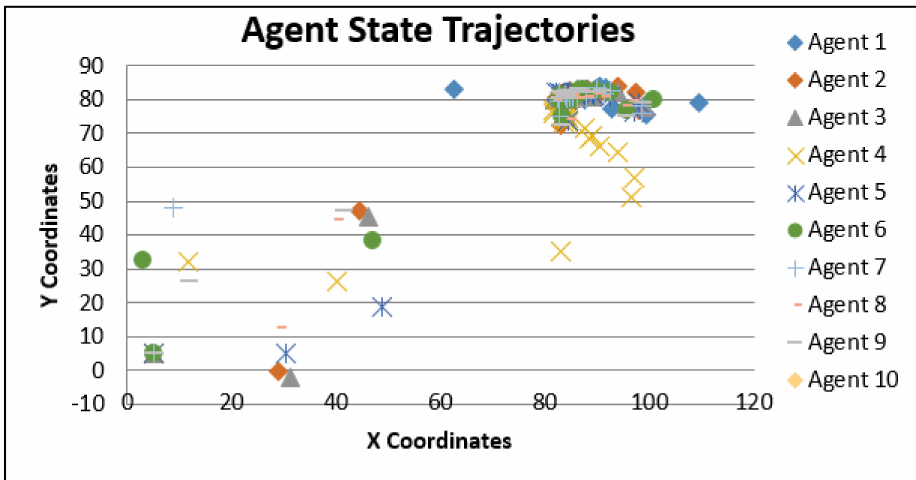
Figure 9. Agent state trajectories